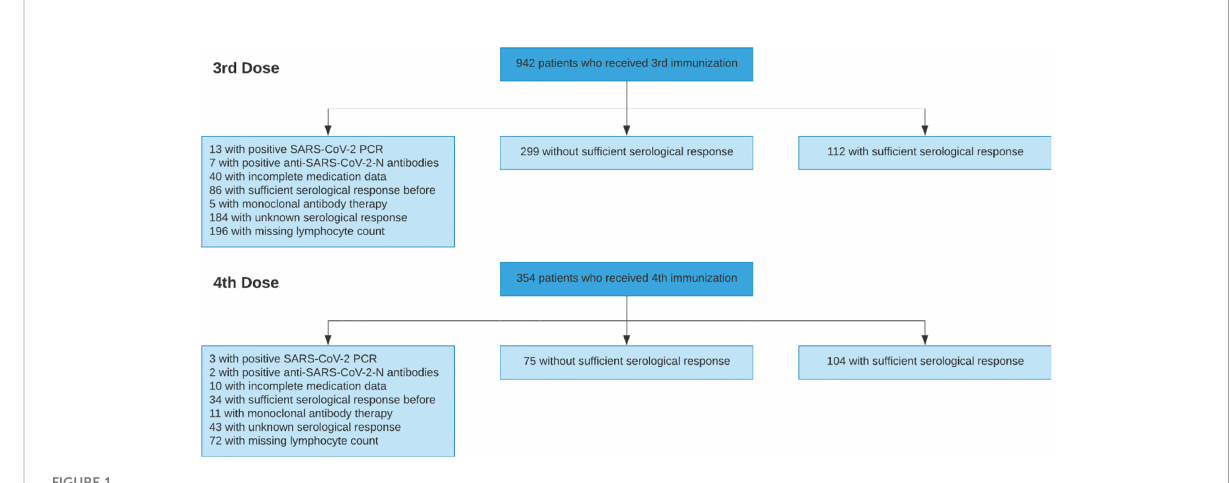
FIGURE 1 Patient fl ow diagram of the development